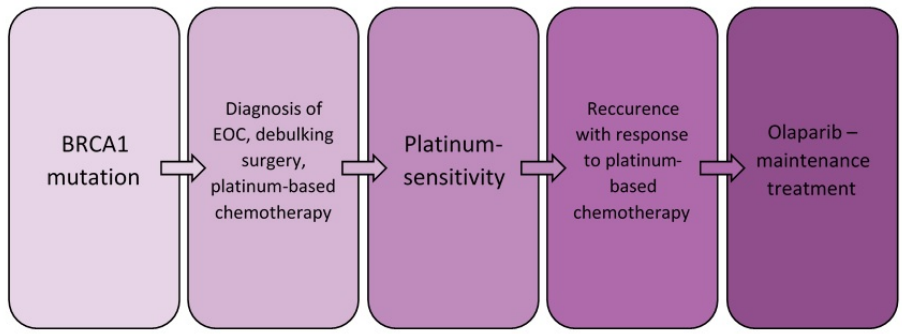
Figure 4. Important points in the diagnostic and therapeutic management of the described patient .